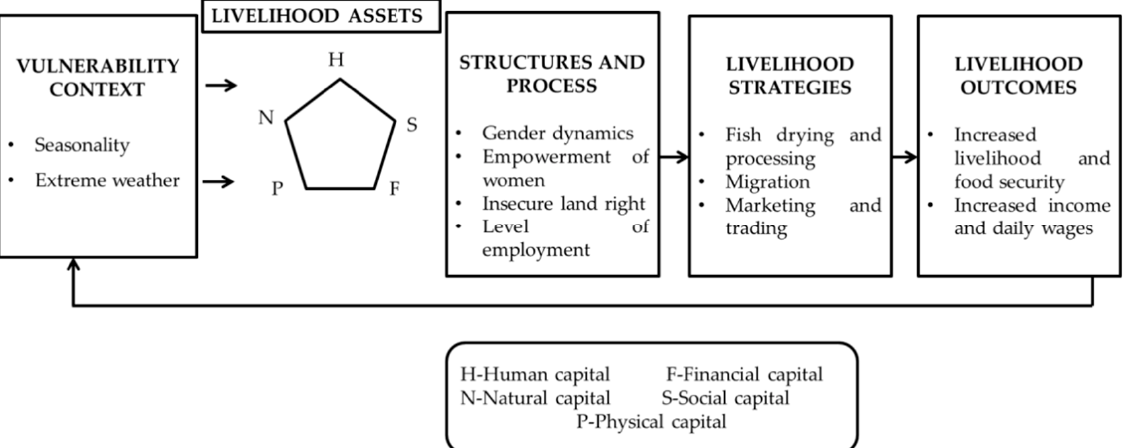
Figure 11. Sustainable livelihood framework of the